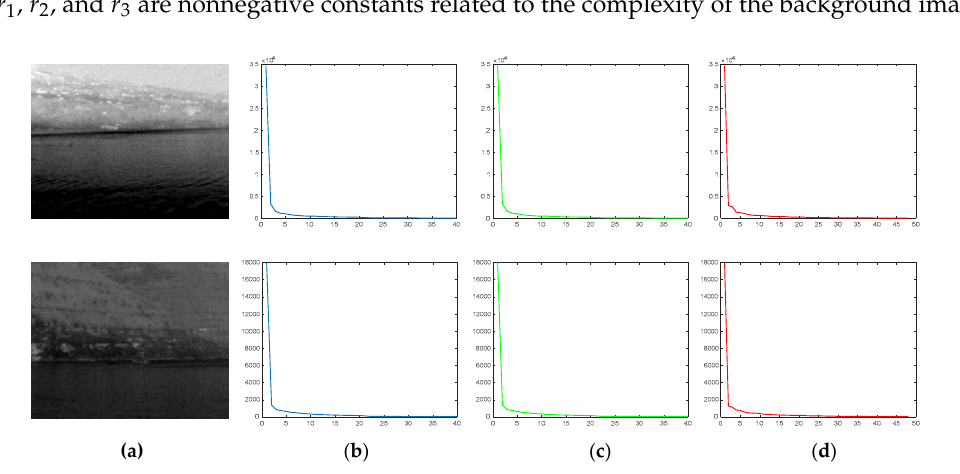
Figure 4. Illustration of the nonlocal self-correlation property of unfolding matrices. ( a ) Two representative scenes; ( b )–( d ) Singular values of mode-1, mode-2, and mode-3 unfolding matrices of the corresponding patch-tensors.